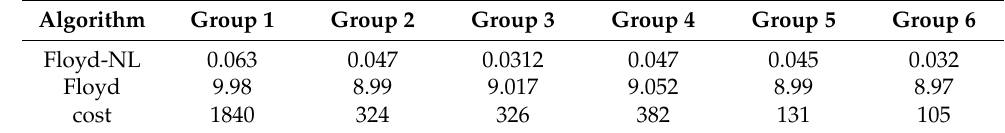
Table 1. A comparison of algorithm running time and cost with Floyd-NL, the Floyd algorithm.